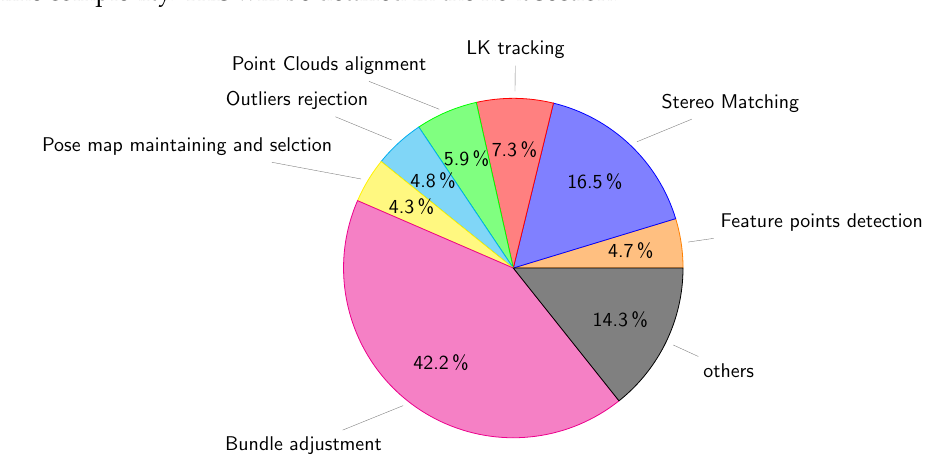
Figure 13. Runtime analysis of the visual odometry system for new pose estimation.